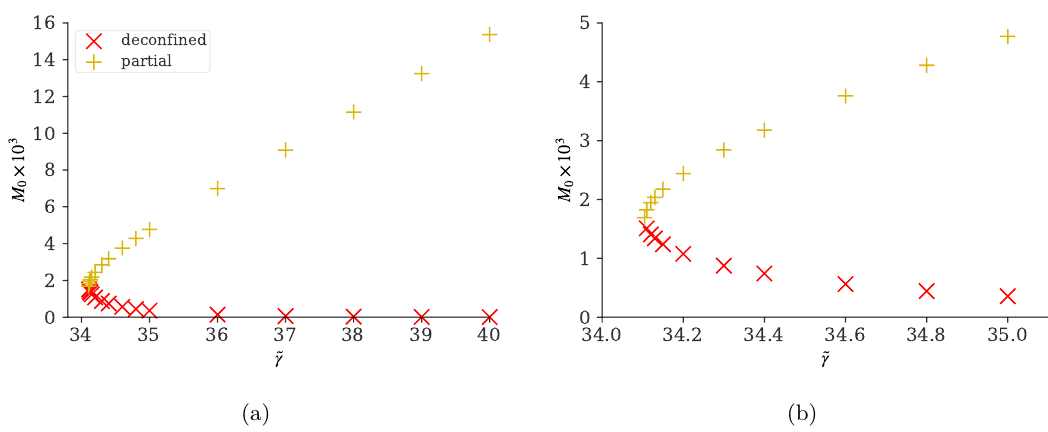
Figure 8. (a) θ = 0 numerical results for | M 0 | , magnified by a factor of 10 3 for clarity, as a function of ˜ γ , for N = 30 , in the deconfined phase (red crosses) and partial phase (gold plus signs). | M 0 | in the deconfined phase becomes zero in the large- N limit. The gold plus signs have larger values, showing that our solutions indeed describe a partial phase. (b) Close-up of (a) near the transition point.